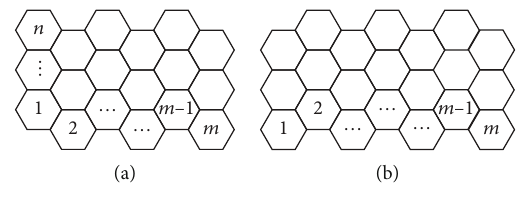
Figure 1: Two types of hexagons.